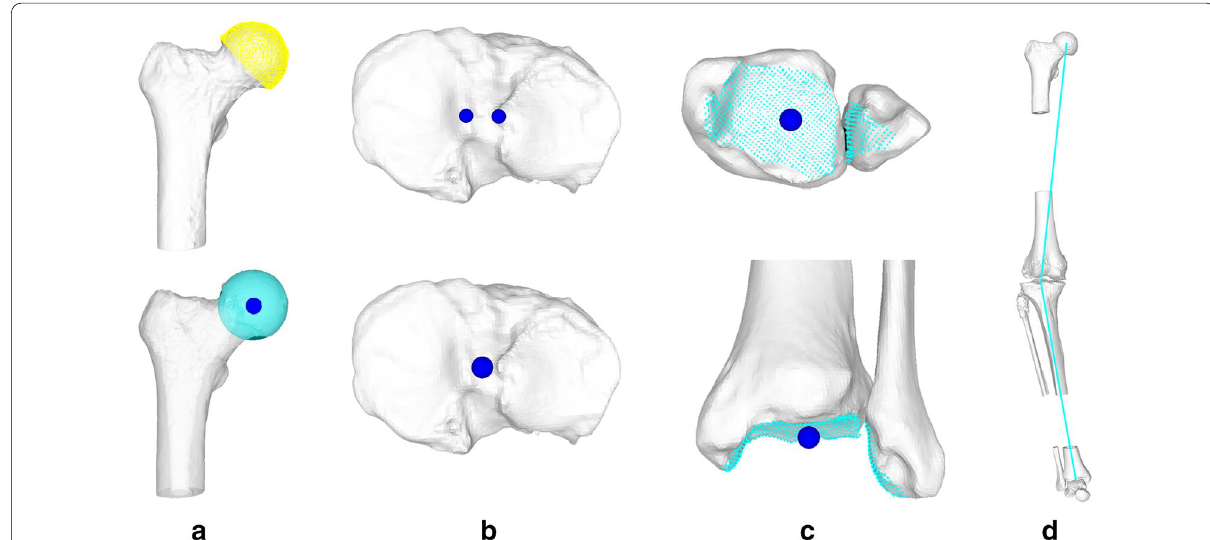
Fig. 4 Calculation of the mechanical axis in 3D. a The HJC is defined as the center of a sphere fitted to the femoral head. b The KJC is located in between the intercondylar eminences on the tibial plateau. c The AJC is defined as the center of all points of the distal tibial and fibular articular